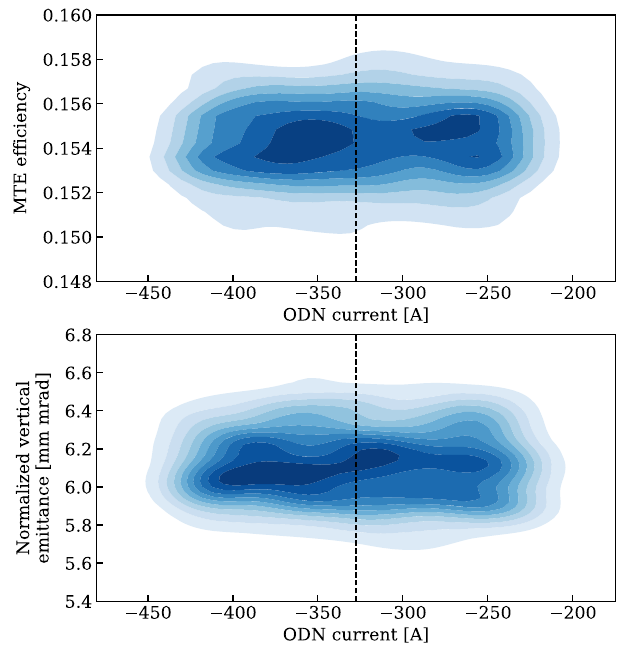
FIG. 4. Distribution of η (upper) and vertical emittance MTE (lower) as a function of the maximum strength of octupoles ODN. No dependence of both parameters on the strength is visible in the explored regime. The vertical dashed lines represent the value of the operational